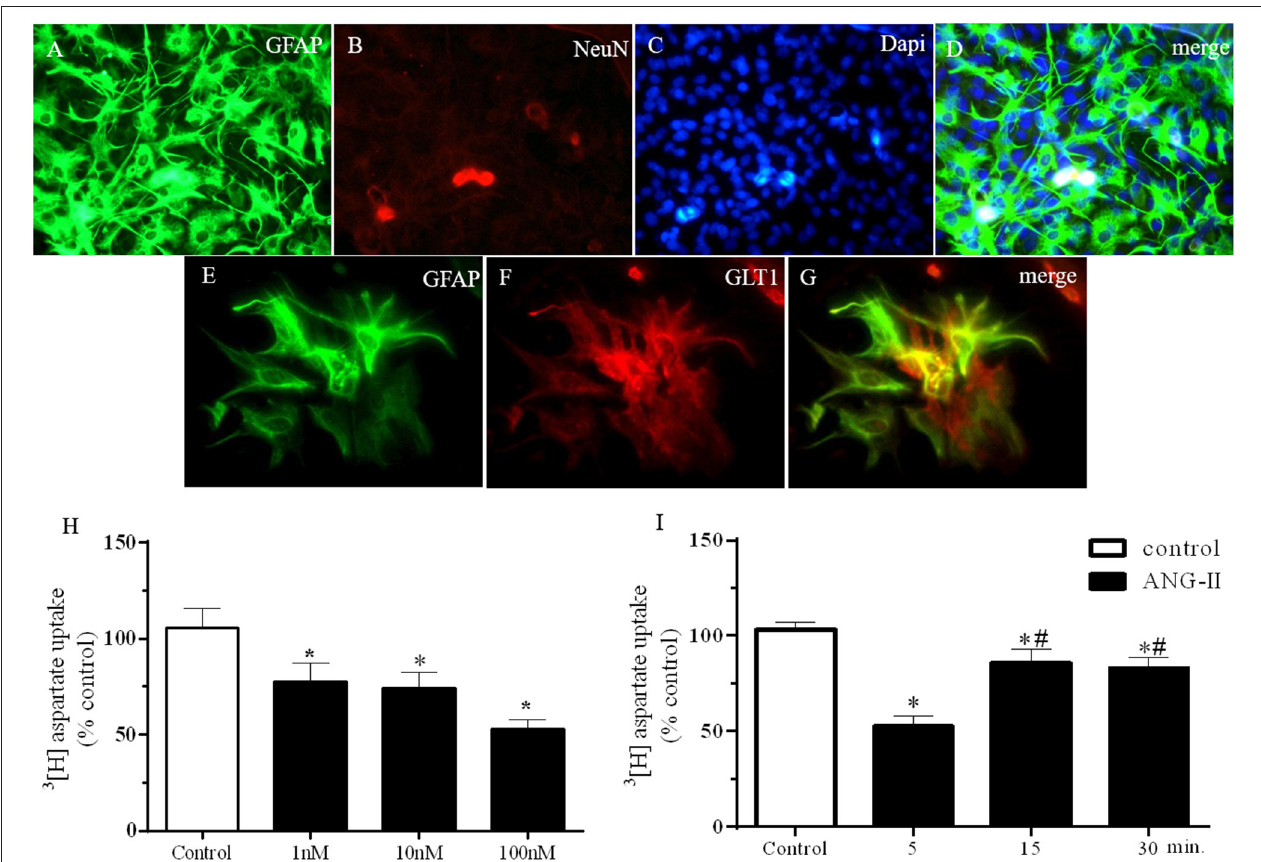
FIGURE 1 | ANG-II decrease 3 [H]-Aspartate uptake in hypothalamic astrocyte primary cultures cells. (A–G) Immunofluorescence showing GFAP (A,E) , NeuN (B) , DAPi (C) , and GLT1 (F) in primary astrocyte culture. Panel (G) merge of panels (A–C) . (H) 3 [H] Aspartate uptake after ANG-II stimulation at 1, 10, or 100 nM during 5 min. (I) 3 [H] Aspartate uptake after ANG-II stimulation at 100 nM during 5 ( n = 11), 15 ( n = 18), or 30 ( n = 26) min. Differences among groups were calculated by One-Way ANOVA followed by the Newman-Keuls post test. Values were expressed as % of control. * p < 0.05 vs. control; # p < 0.05 vs. 15 and 30 min.